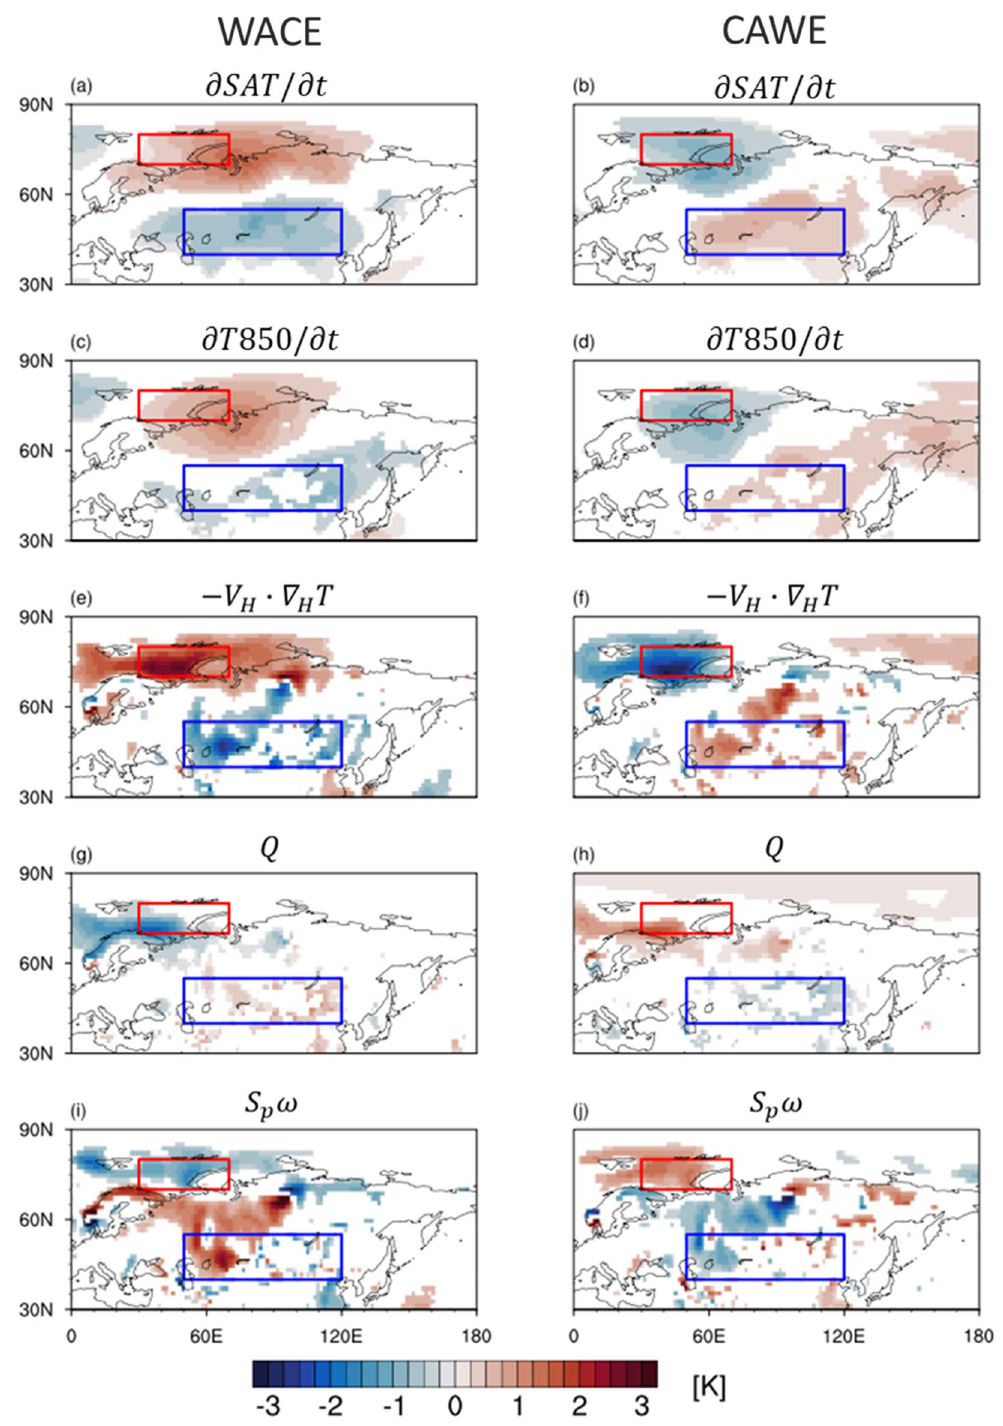
Figure 4. ( a , b ) The SAT tendency, ( c , d ) T850 tendency, ( e , f ) horizontal temperature advection, ( g , h ) diabatic heating, ( i , j ) adiabatic heating averaged from -5 to 0 days for (left) WACE and (right) CAWE cases. Note that all values are slightly smoothed by applying a nine-point local smoothing once and the underground values are excluded. Only the values that are statistically significant at the 95% confidence level are shaded. Figures were created with the NCAR Command Language 6.6.2 (http://dx.doi.org/10.5065/D6WD3